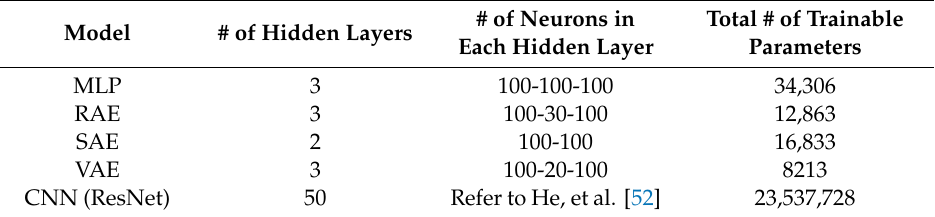
Table 1. Layer configurations of deep learning (DL) models applied.